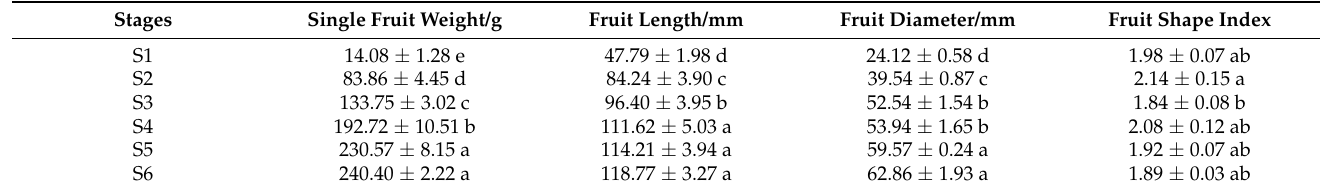
Table 2. Dynamic changes in appearance quality during S. obovatifoliola subsp. urophylla fruit development. Stages Single Fruit Weight/g Fruit Length/mm Fruit Diameter/mm Fruit Shape Index